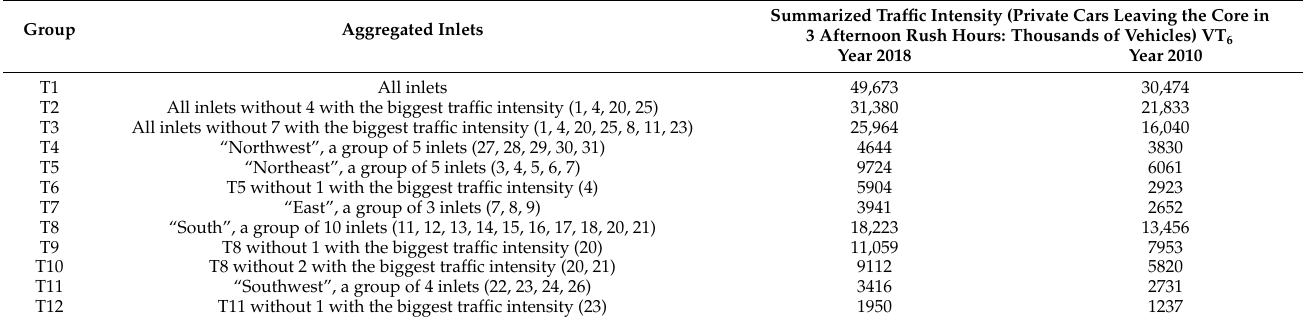
Table 4. Groups aggregating traffic parameters for the Wrocław agglomeration.